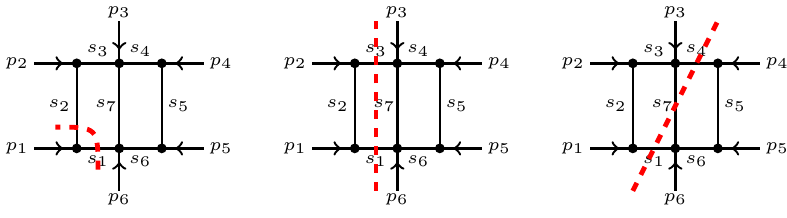
Figure 3 . Particular two-loop topology with six vertices and seven internal